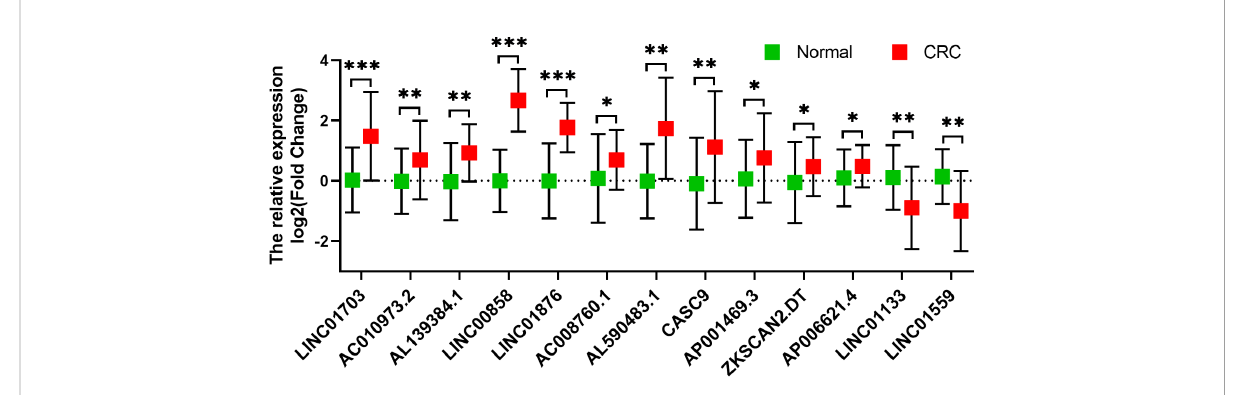
FIGURE 9 Validation of the expression of the selected metabolism-related lncRNAs in 12 pairs of clinical tissues (n=12). The expression levels of LINC01703, AL139384.1, LINC00858, LINC01876, AC008760.1, AL590483.1, CASC9, AP001469.3, ZKSCAN2.DT, AP006621.4 and AC010973.2 were signi fi cantly higher in CRC tissue samples, while LINC01559 and LINC01133 were signi fi cantly lower in CRC tissue samples. *p < 0.05, **p < 0.01, ***p <